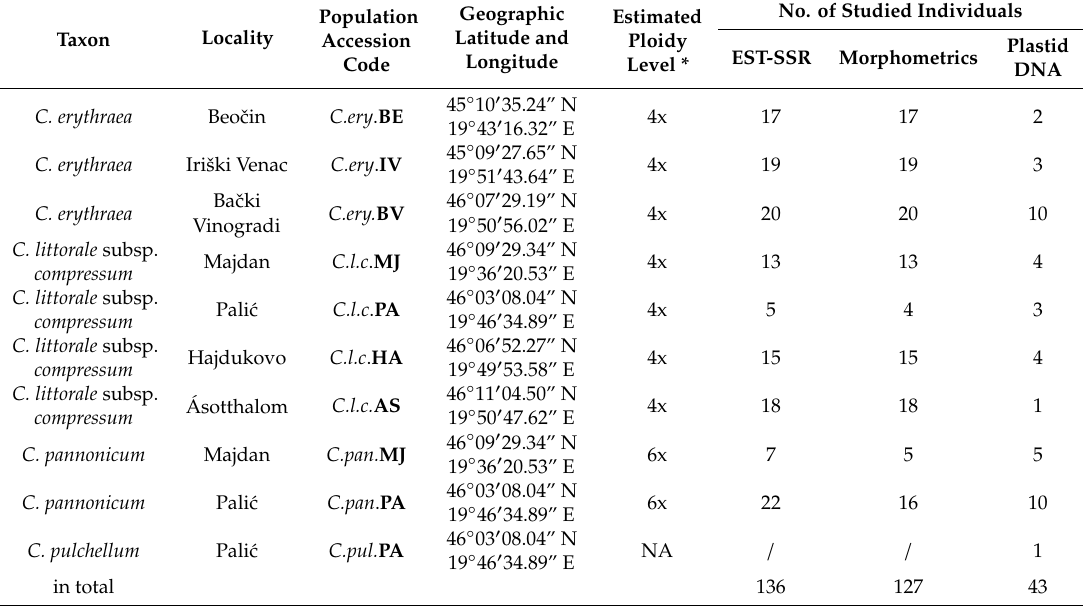
Table 3. Centaurium erythraea , C. littorale subsp. compressum and C. pannonicum accessions used in the study.